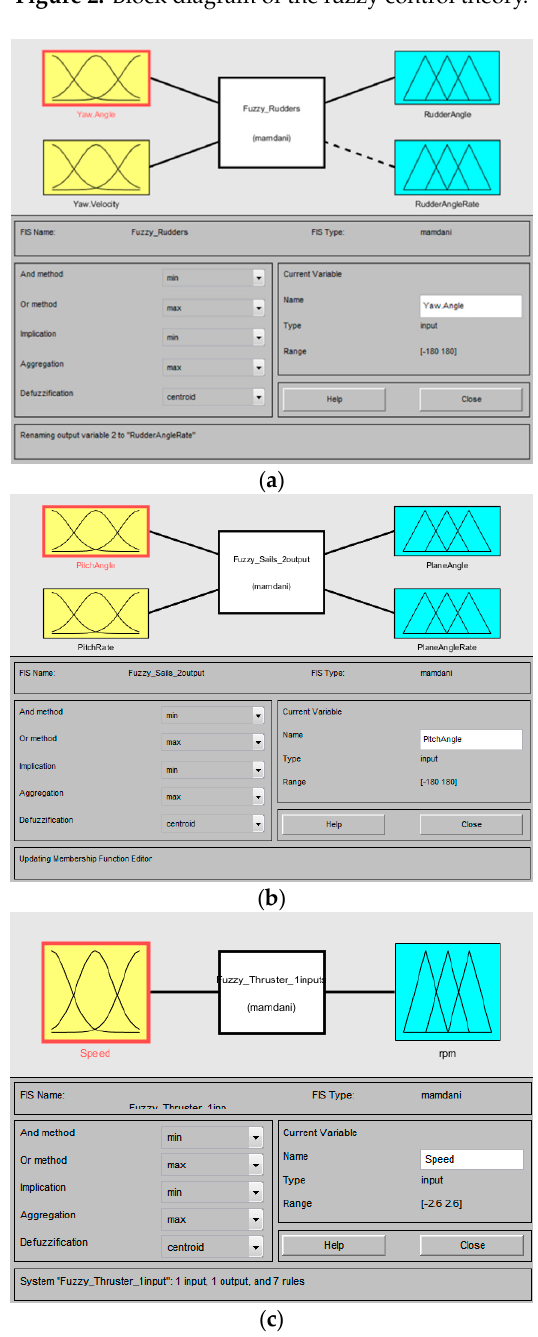
Figure 3. Fuzzy controller for ( a ) the vertical rudder plane; ( b ) the horizontal rudder plane; and ( c ) the propeller, respectively.